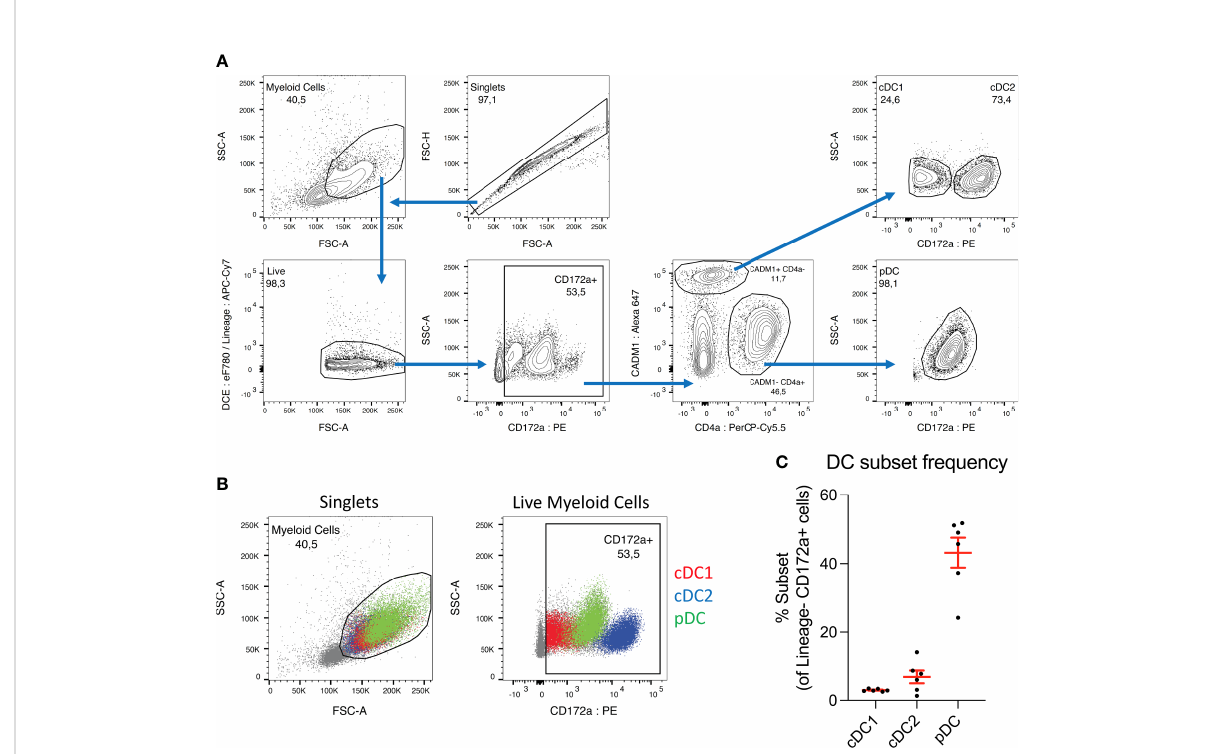
FIGURE 1 pDC dominate the DC population in porcine blood. (A) Sorting strategy used to isolate dendritic cell subsets from porcine PBMC. CD3+ and gd -TCR1+ T cells, CD21+ and IgM+ B cells and CD14+ monocytes were fi rst depleted by magnetic cell separation, and the negative fraction was then taken forward for FACS sorting. Cell aggregates were excluded and myeloid cells selected based on size (FSC-A) and granularity (SSC-A). Cells were treated with a fi xable viability dye, and labelled, dead cells excluded (DCE: eF780). In parallel, any remaining CD3+, gd -TCR1+, CD21+, IgM+ or CD14+ cells were labelled and excluded (Lineage: APC-Cy7). CD172a+ cells were selected, and within this population, CADM1+ CD4a- cDC were selected and further divided into CD172a low cDC1 and CD172a high cDC2. The CADM1- CD4a+ cell population was also selected, which consist almost entirely of CD172a mid pDC. (B) Overlays of sorted DC subsets within myeloid cell (left) and CD172a+ (right) gates. Presented with cDC2 (blue) as the bottom layer, with cDC1 (red) above and pDC (green) on top. Overlays were used for adjusting gating prior to sorting. (C) Percentages of each DC subset within the CD172a+ gate. Each dot represents one pig, n =